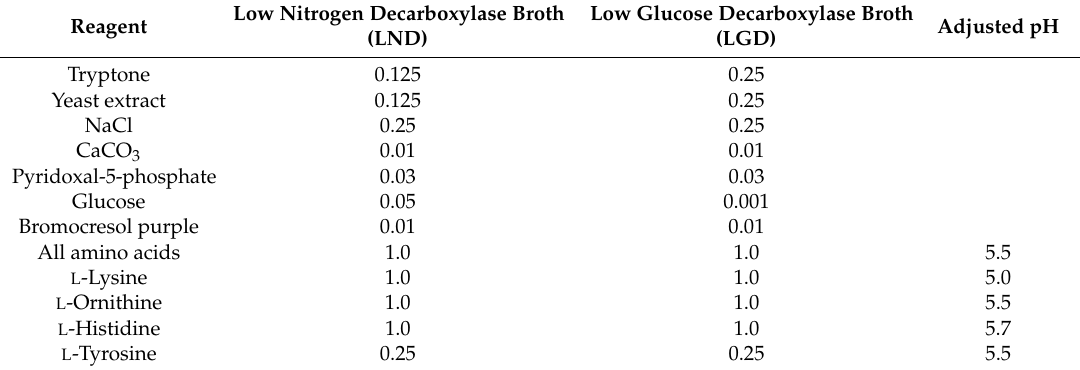
Table 1. Composition of broth media (g/100 mL)) used to evaluate decarboxylase ability of strains isolated from